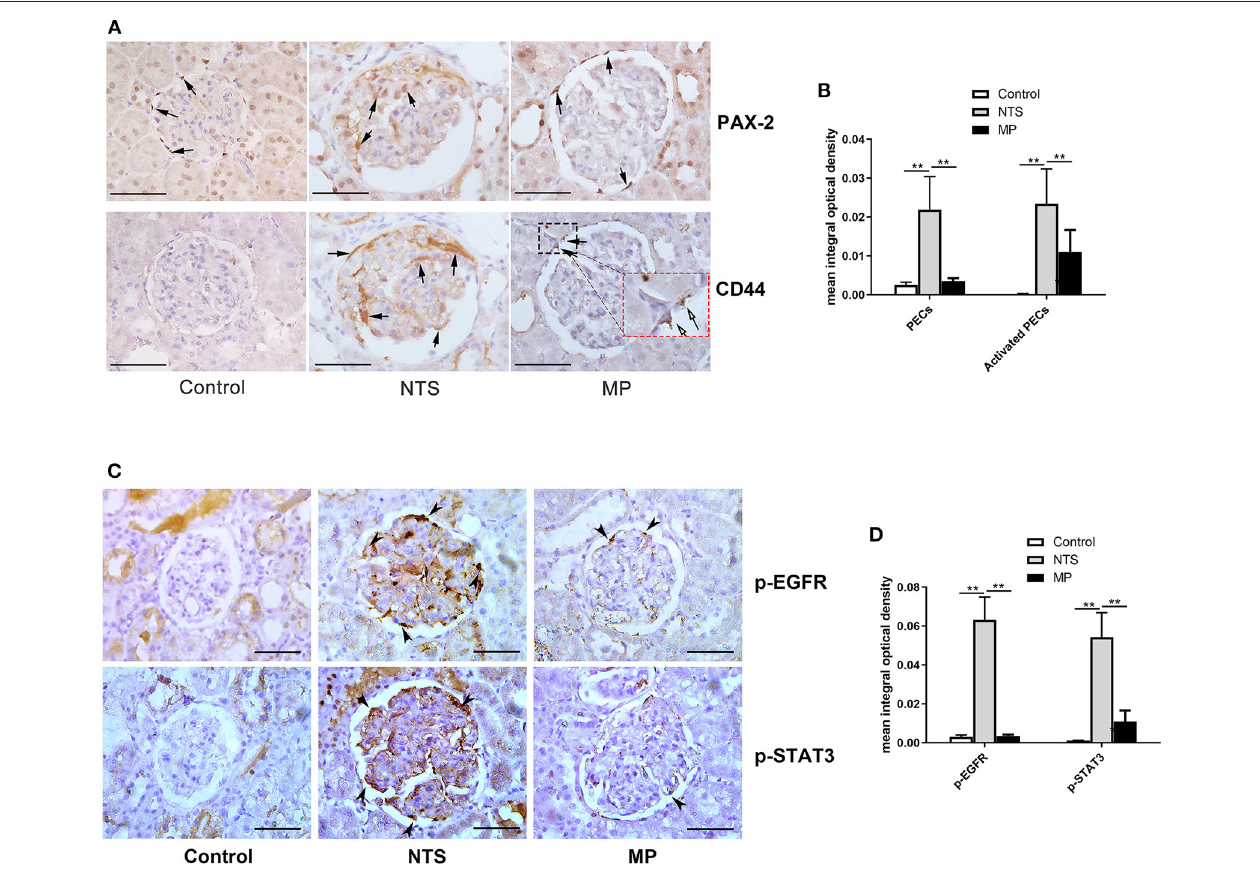
FIGURE 4 | Glucocorticoid treatment suppressed proliferation of PECs and activation of EGF signaling in podocytes of NTS rats. (A) Immunohistochemistry staining for PAX-2 (PECs) and CD44 (activated PECs) in sections of kidney biopsies from rats treated with NTS alone, NTS + MP, and NTS + MP + RU486, respectively ( n = 5 per group). Quantification of staining intensity in glomeruli is shown in (B) ; (C) Immunohistochemistry staining for p-EGFR (Tyr1068) and p-STAT3 (Tyr705) in sections of kidney biopsies from the corresponding rats in (A) . Quantification of the staining intensity for p-EGFR and p-STAT3 in glomerular tuft is shown in (D) . Arrows denote positive staining in the glomeruli; ** P < 0.01. Scale bars, 50 µ